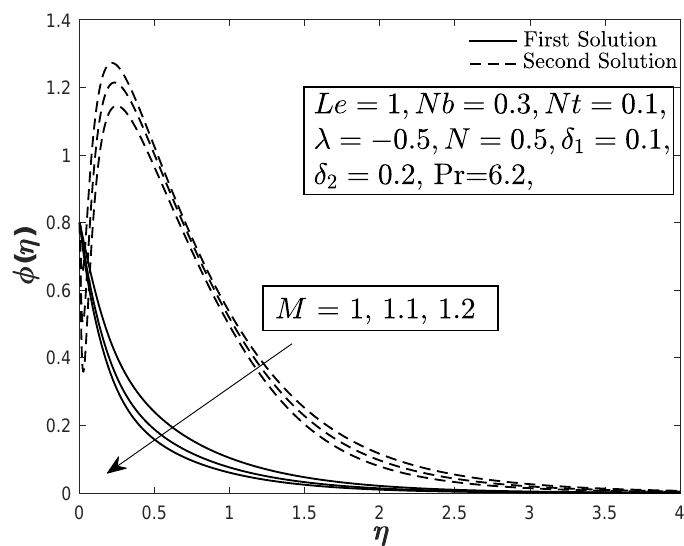
Figure 14. Effect of magnetic parameter M on the concentration profile.